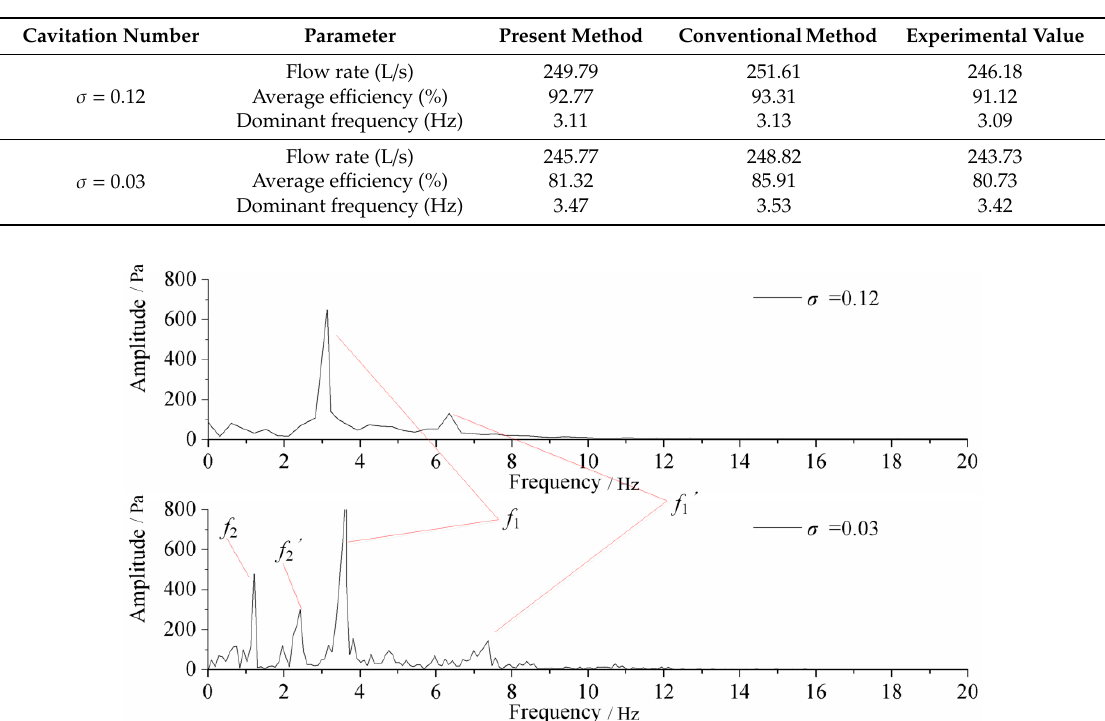
Table 4. Performance comparison between simulation methods and experimental data with original runner.